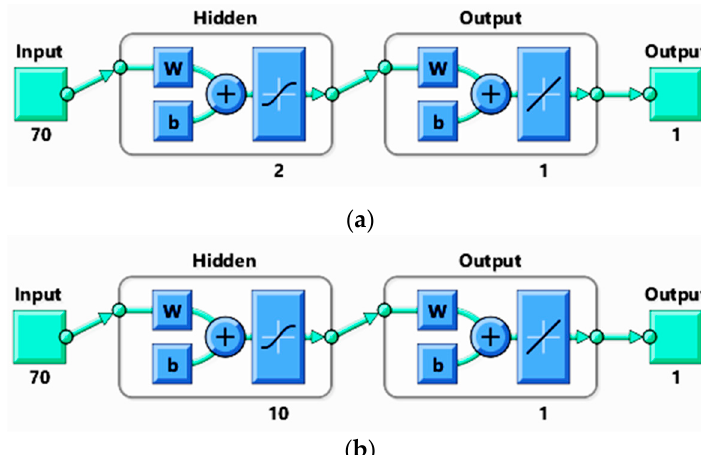
Figure 2. Neural network diagrams used in this study: ( a ) using two hidden layers and ( b ) using 10 hidden layers. As input parameters, the four aforementioned clusters have been used.